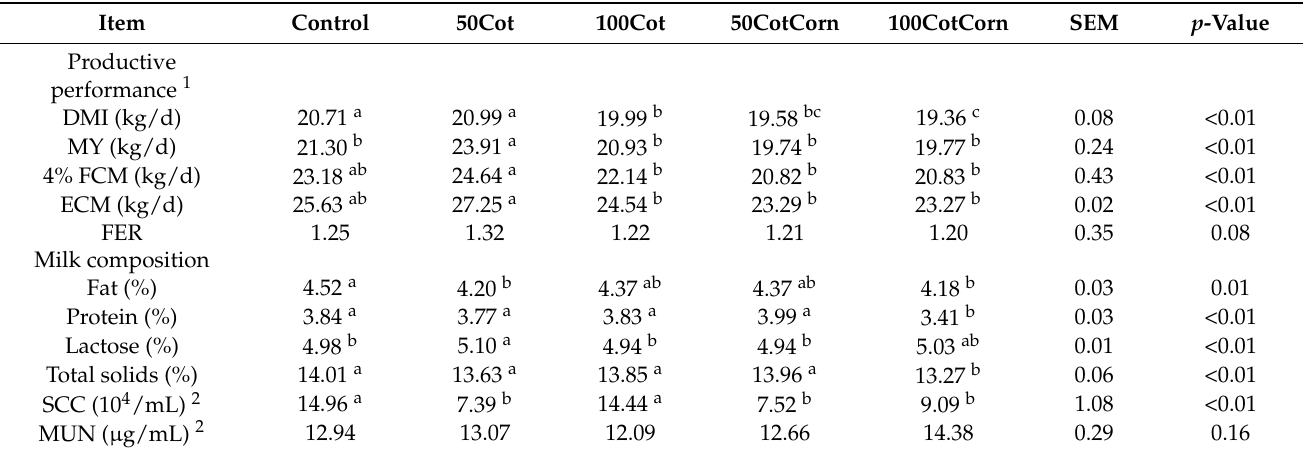
Table 4. Productive performance and milk composition of dairy cows fed diets containing mildewy corn meal and cottonseed.